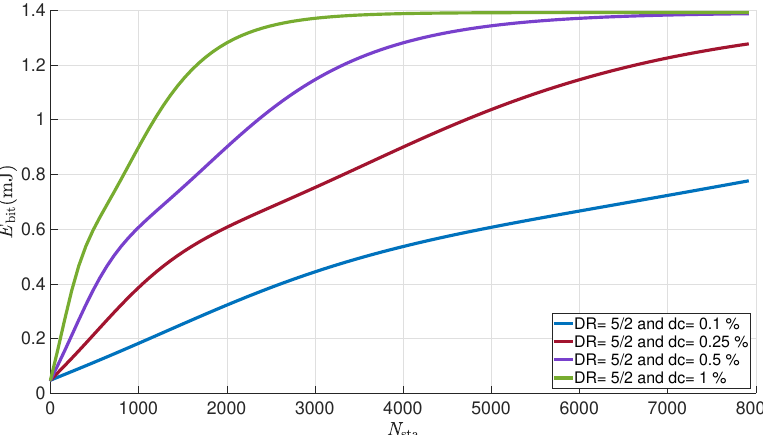
Figure 21. Average energy consumed per useful bit by a LoRa sensor for various duty cycle vs. number of nodes in the network (FPayload = 50 bytes; NR = 8; P tx = 14 dBm; d = 1